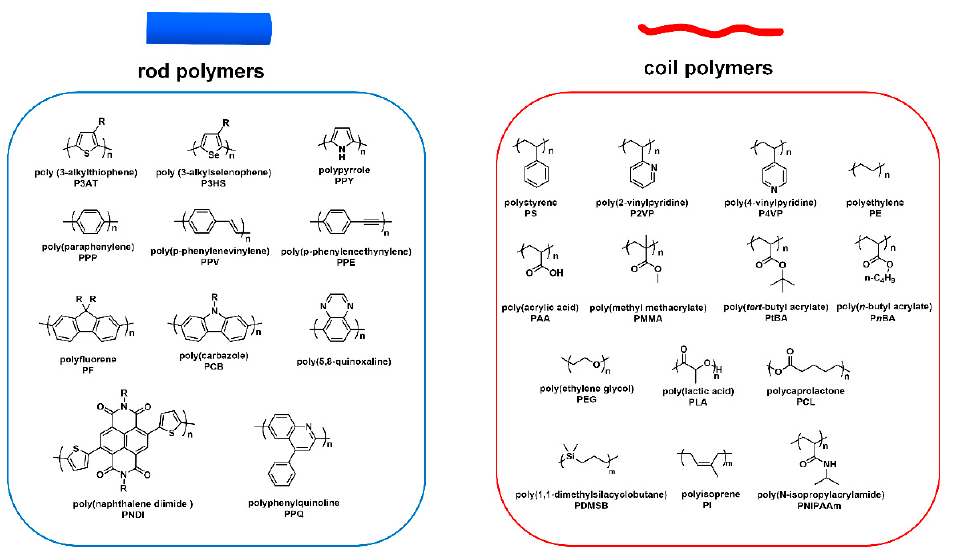
Figure 4. Representative chemical structures for rod and coil